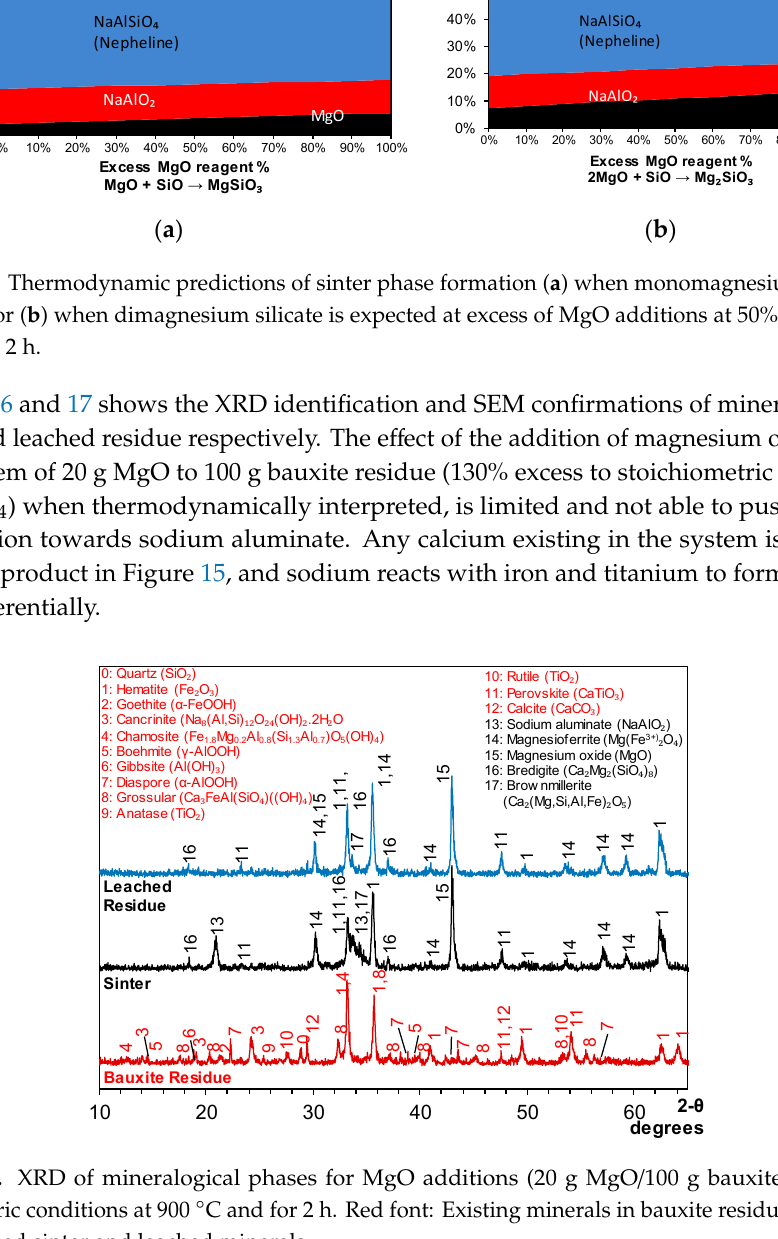
12 of 20 Figure 13. XRD of mineralogical phases for lime additions (20 g CaO/100 g bauxite residue, equivalent to 80% excess CaO addition for Ca 2 SiO 4 formation), and 50% excess soda at 900 °C and for 2 h. Red font: Existing minerals in bauxite residue; black font: Transformed sinter and leached minerals. ( a ) ( b ) Figure 14. SEM (scanning electron microscope) mineral identifications in CaO, Na 2 CO 3 and bauxite residue ( a ) Sinter product; (1) Sodium aluminate, (2) Calcium ferrite, Calcium titanate, (3) Calcium silicate, sodium calcium silicate; and ( b ) Leached residue; (4) Calcium ferrite, calcium silicate, (5)